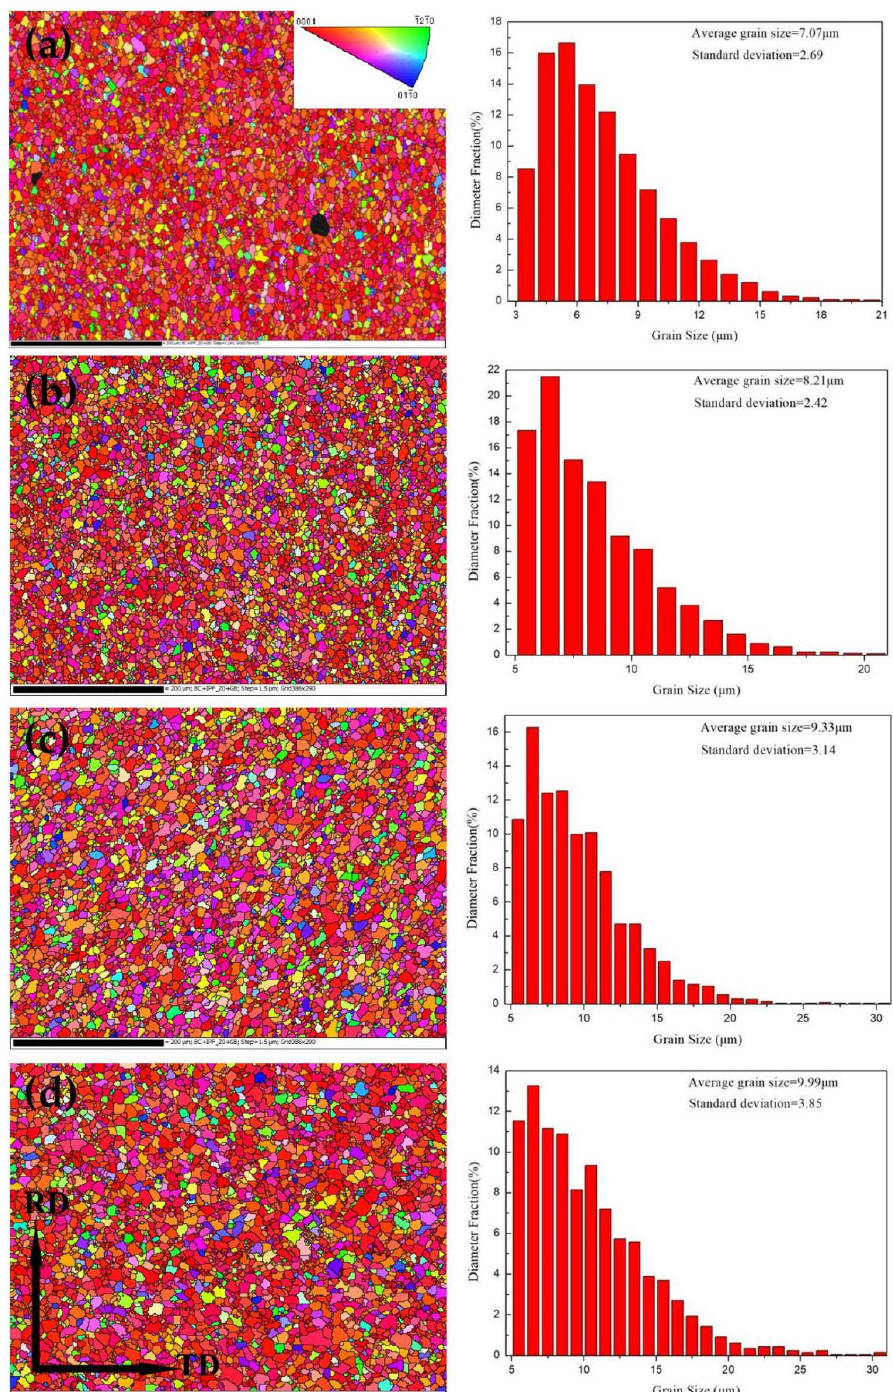
Figure 3. Inverse pole figures and grain size distribution of AZ31 alloys HSRMFed at different temperatures as Δε = 1.32: ( a ) 250 °C, ( b ) 300 °C, ( c ) 350 °C, ( d ) 400 °C.